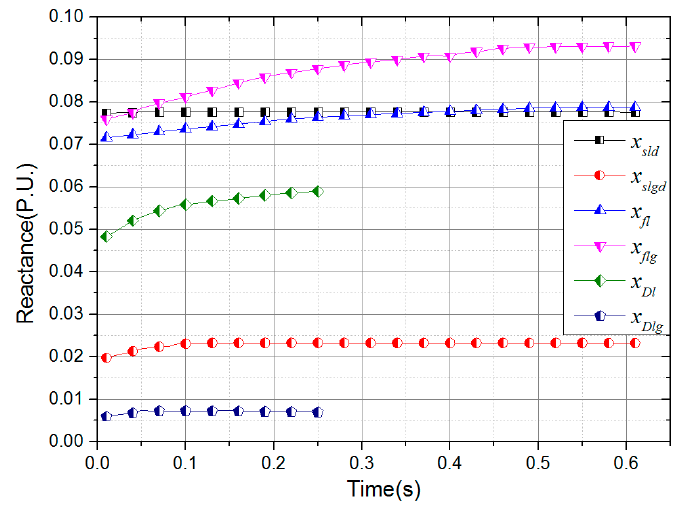
Figure 10. Variation in the d -axis leakage inductances during the transient process.